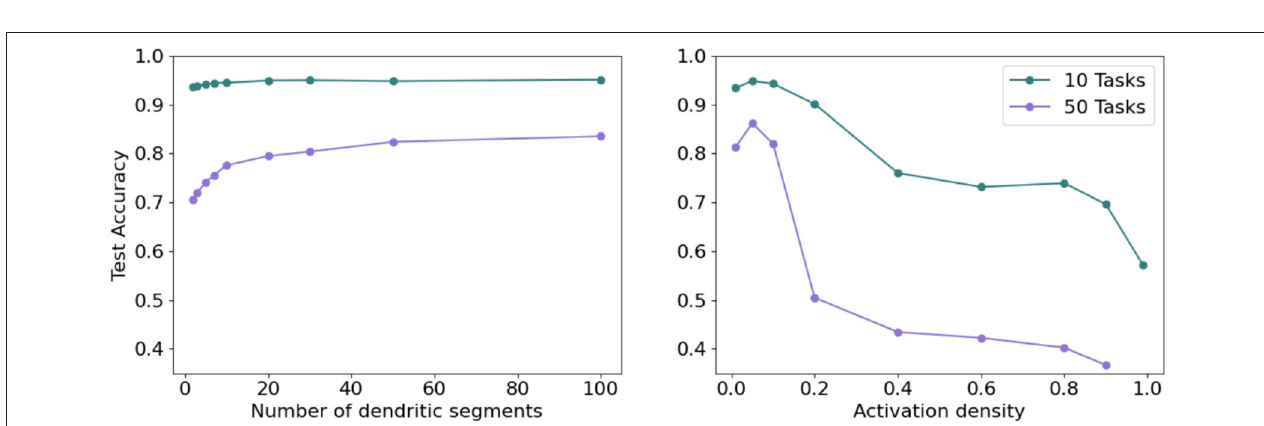
FIGURE 13 | (Left) Final accuracy on test examples across all tasks when varying the number of dendritic segments per neuron and keeping activation sparsity constant when learning 10 (top) and 50 (bottom) permutedMNIST tasks. (Right) Final accuracy on test examples across all tasks for a fixed number of dendritic segments per neuron and varying activation density level on 10 (top) and 50 (bottom) permutedMNIST